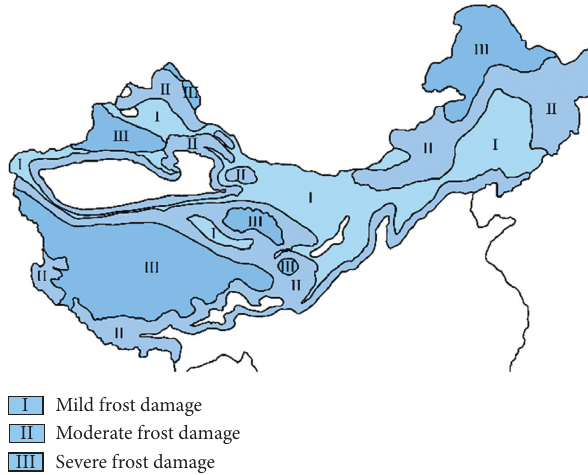
Figure 1: Distributions of frost damage in